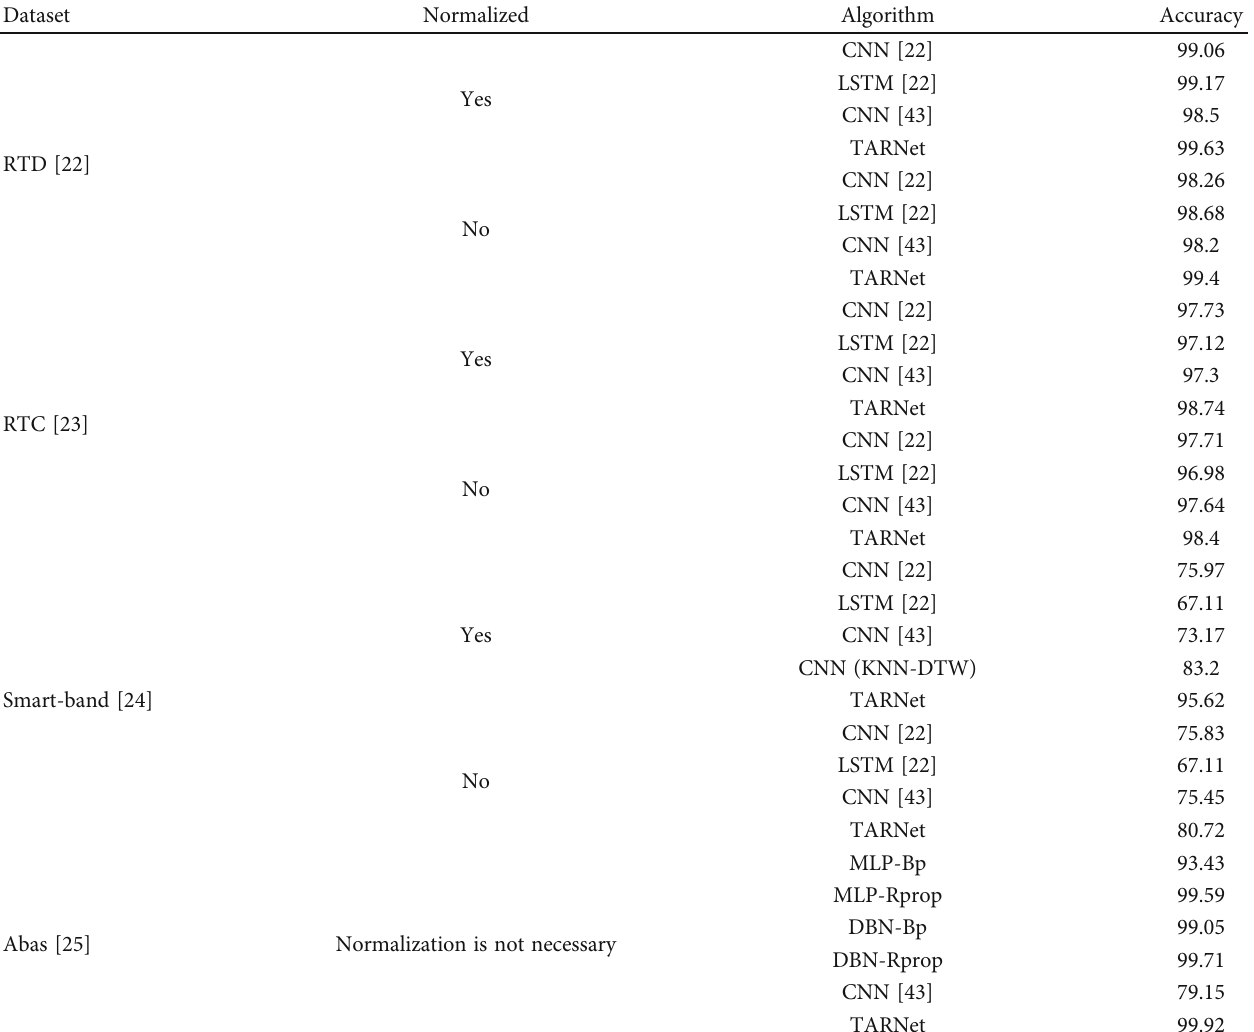
Table 3: Performance